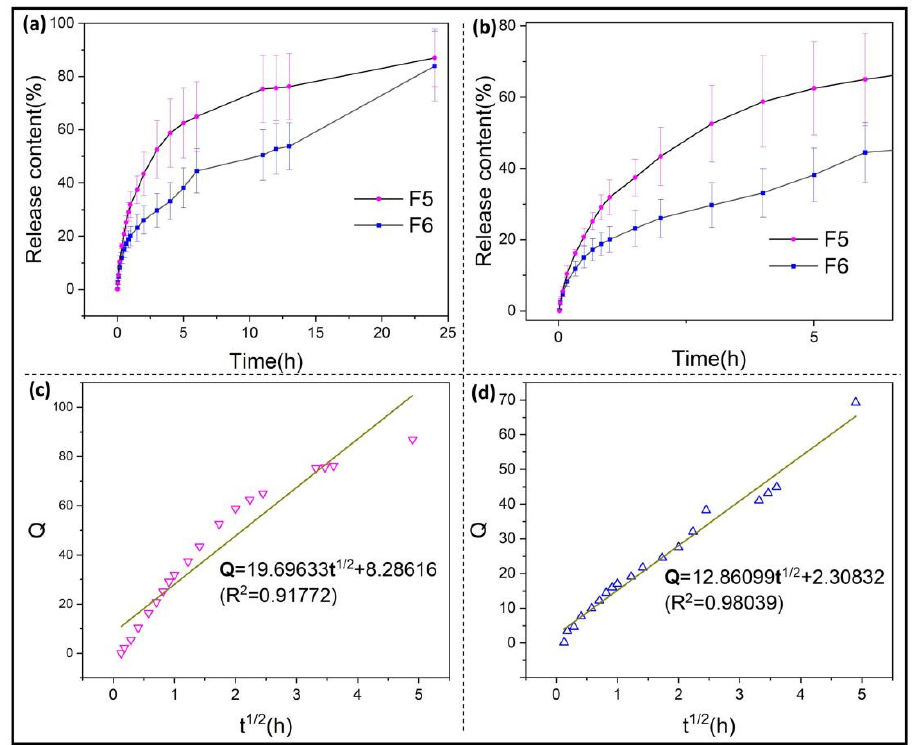
Figure 8. Release profiles of electrospun nanofiber membranes: ( a ) release characteristics of F5 (coaxial fiber loaded with RE in the core structure) and F6 (coaxial fiber loaded with RE in both core and sheath structure) in 24 h; ( b ) partial enlarged view of F5 and F6 curve in 6 h; ( c ) regressed equation of RE release profile from F5; ( d ) regressed equation of RE release profile from F6.